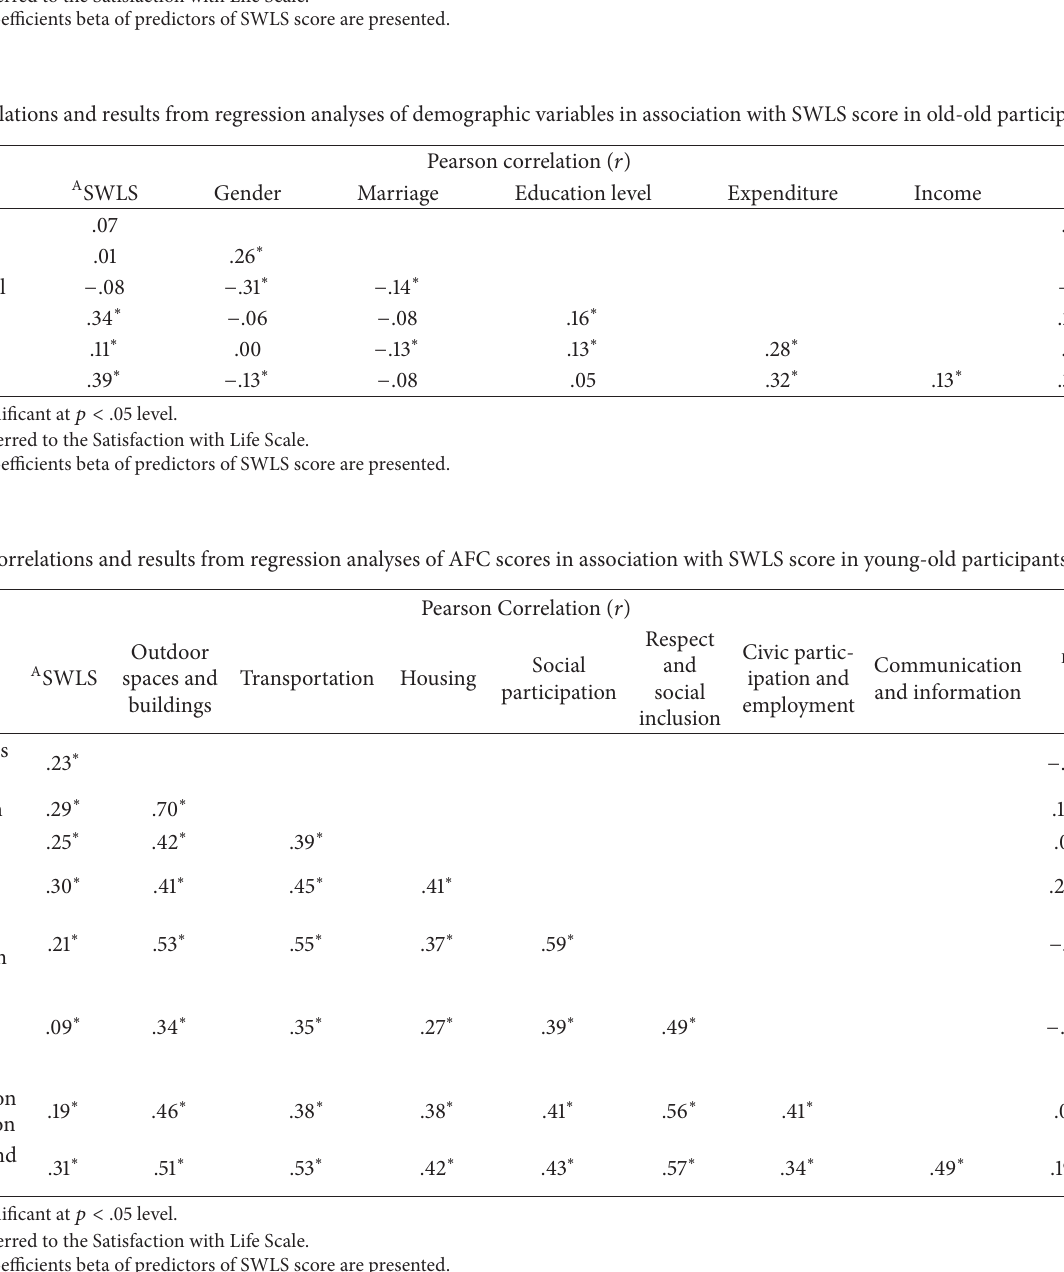
Table 4: Correlations and results from regression analyses of demographic variables in association with SWLS score in old-old participants. Variables